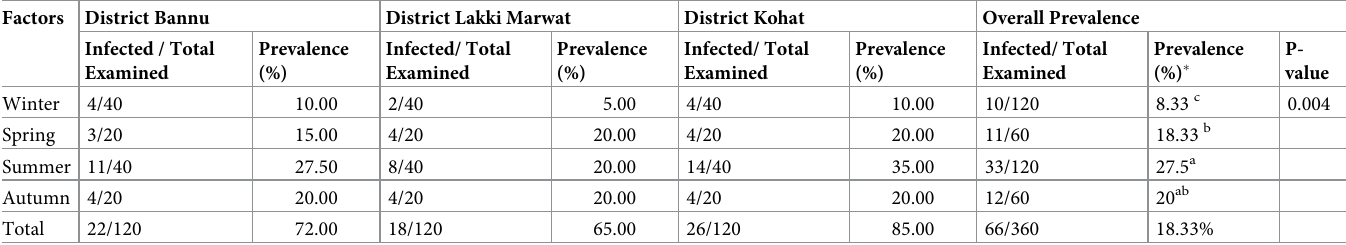
Table 1. Season wise prevalence of Cryptosporidium infection in sheep detected by simple microscopy.